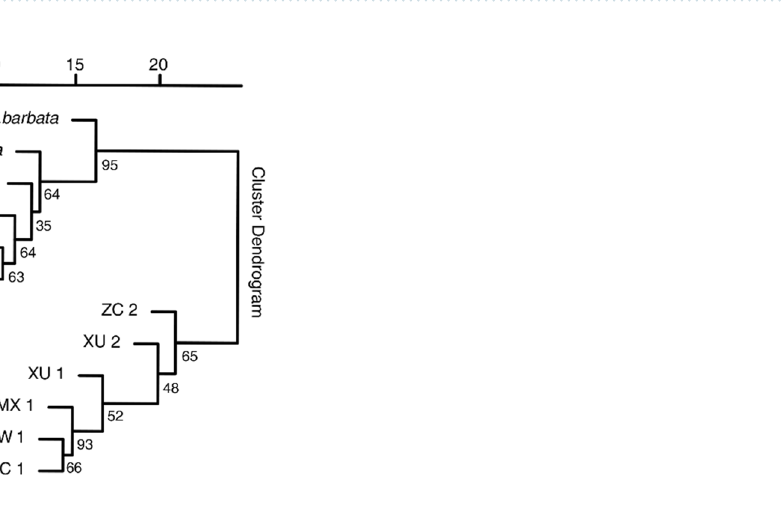
Figure 5. Genetic similarity coefficient analysis of six accessions of P. palustre and six related species performed based on the neighbor-joining method using the pvclust R package. Numbers at the nodes are bootstrap values from 1000